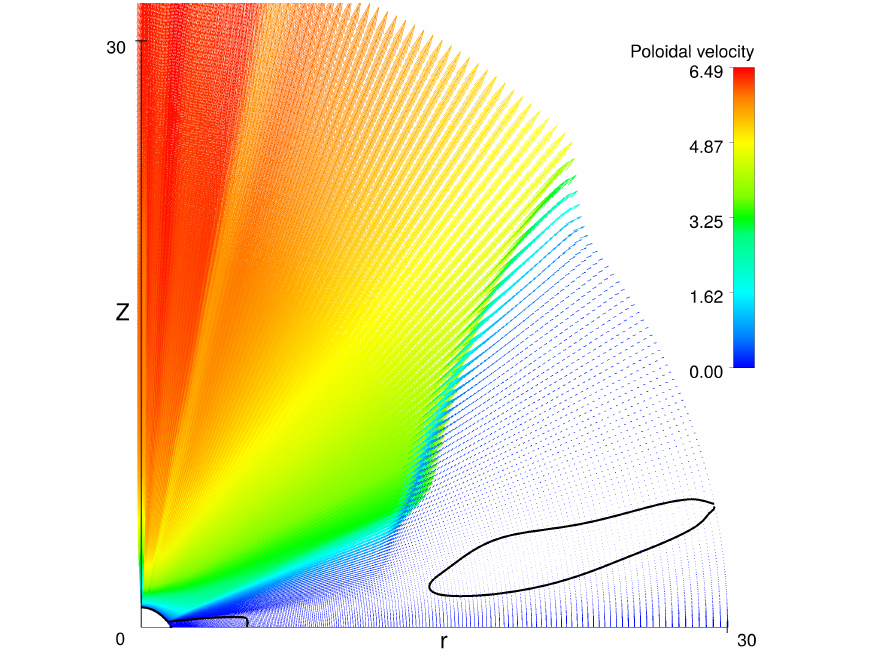
Figure 8. The field of velocity in the poloidal plane at ω = 1.01. Thick black solid line—sound line for the poloidal velocity.